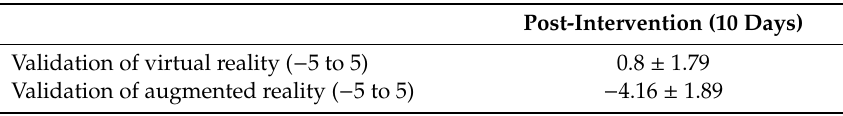
Table 3. Validation of virtual reality and augmented reality.